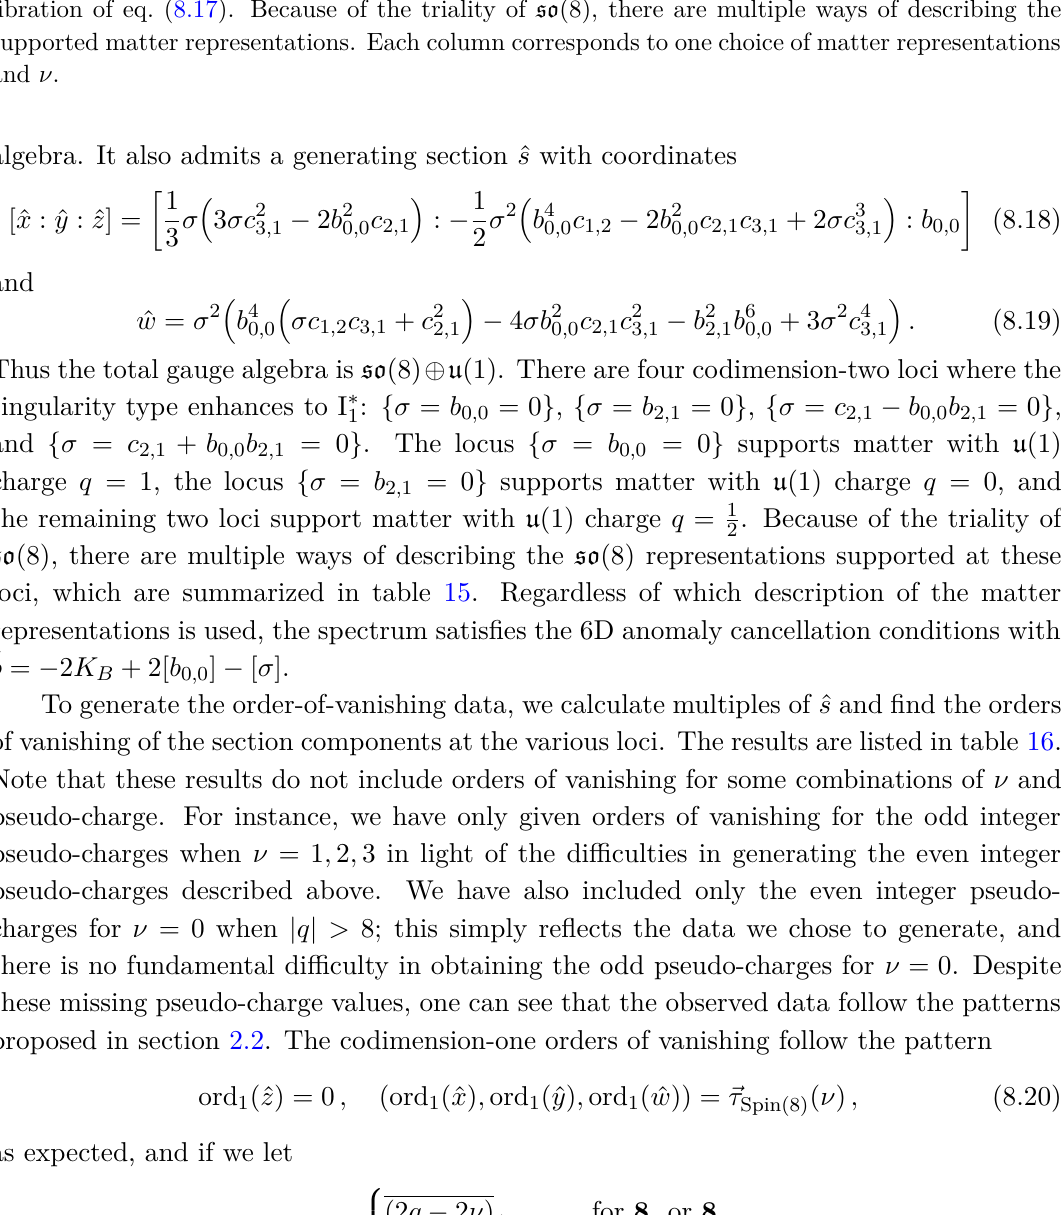
loci in the elliptic → I ∗ 0 1